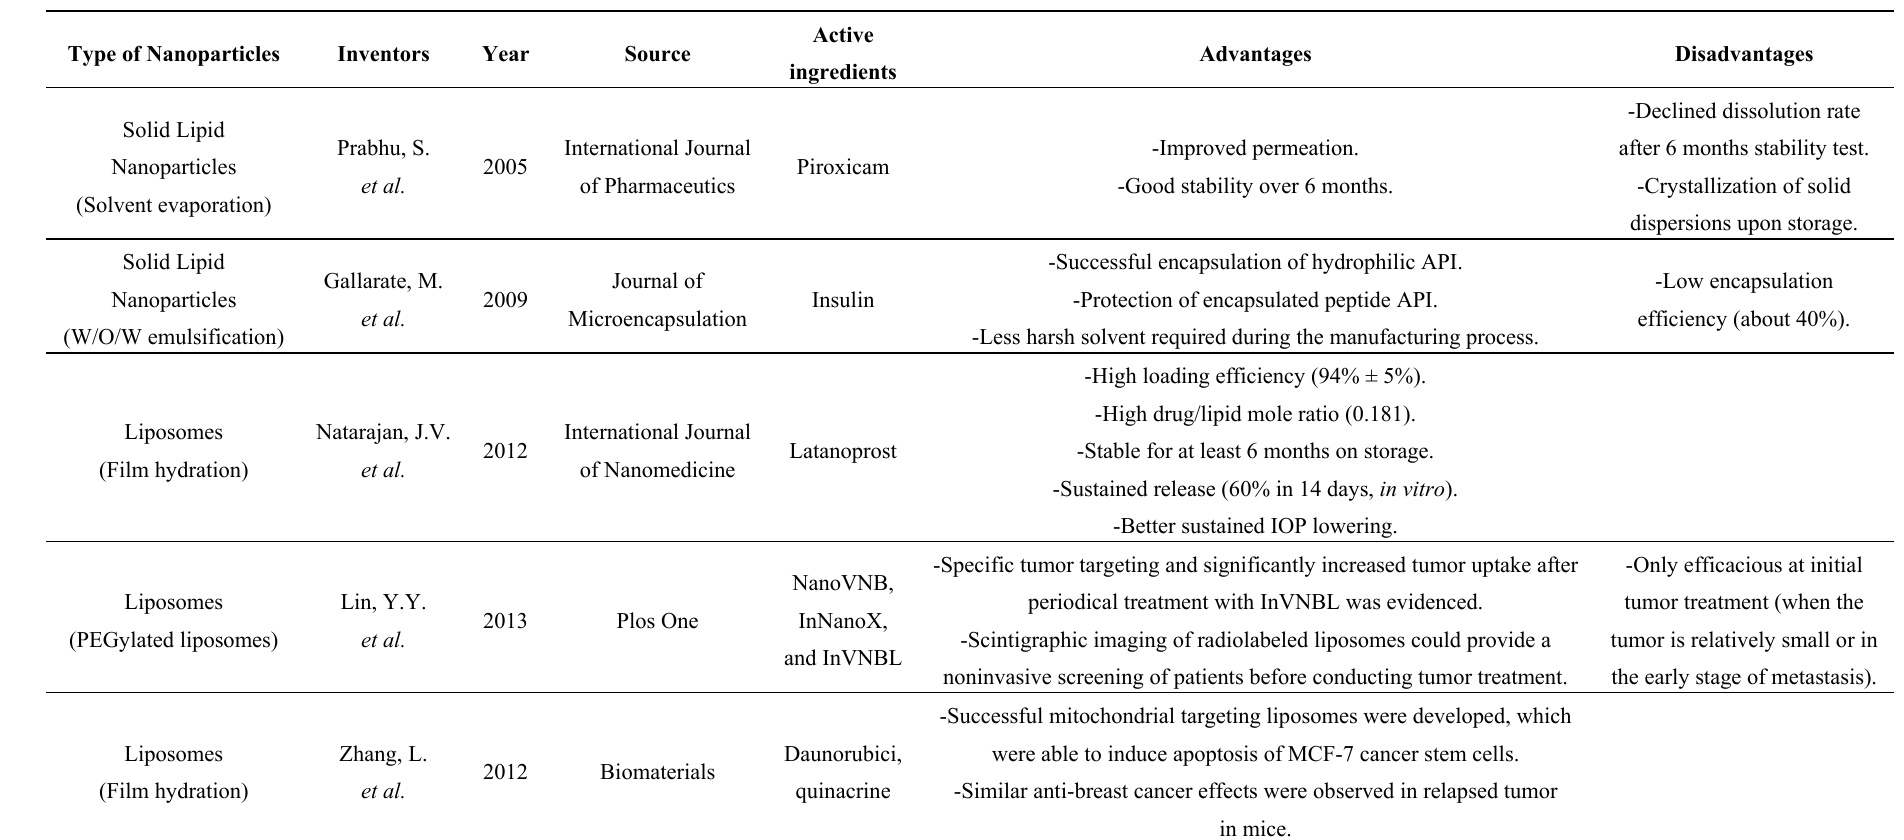
Table 1. Summary: Recent nanoparticulated drug delivery